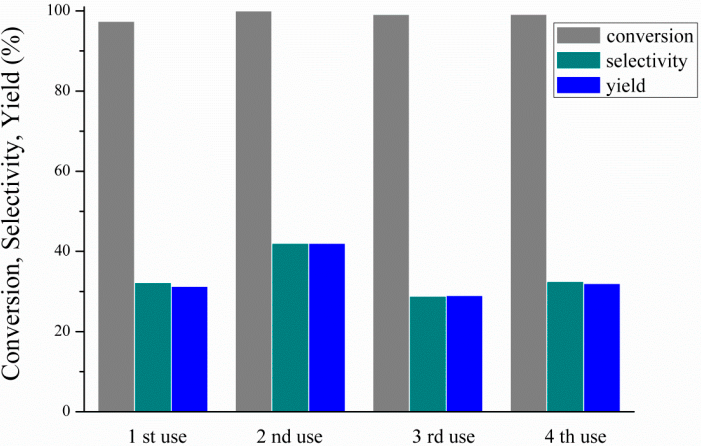
Figure 3. Reusability tests of the Pt/Fe-Al catalysts: 250 °C, 4 h, 7.1 wt% EtOH, 11.3 wt% glycerol (ethanol/glycerol molar ratio = 1.25) and water, catalyst/glycerol + ethanol weight ratio = 0.06.